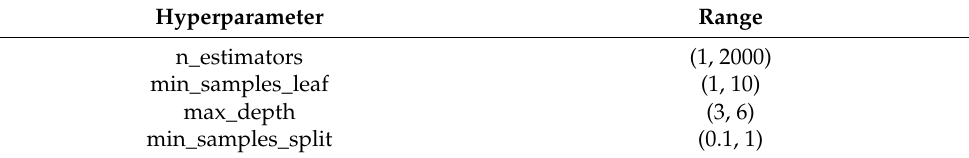
Table 5. Hyperparameter range for